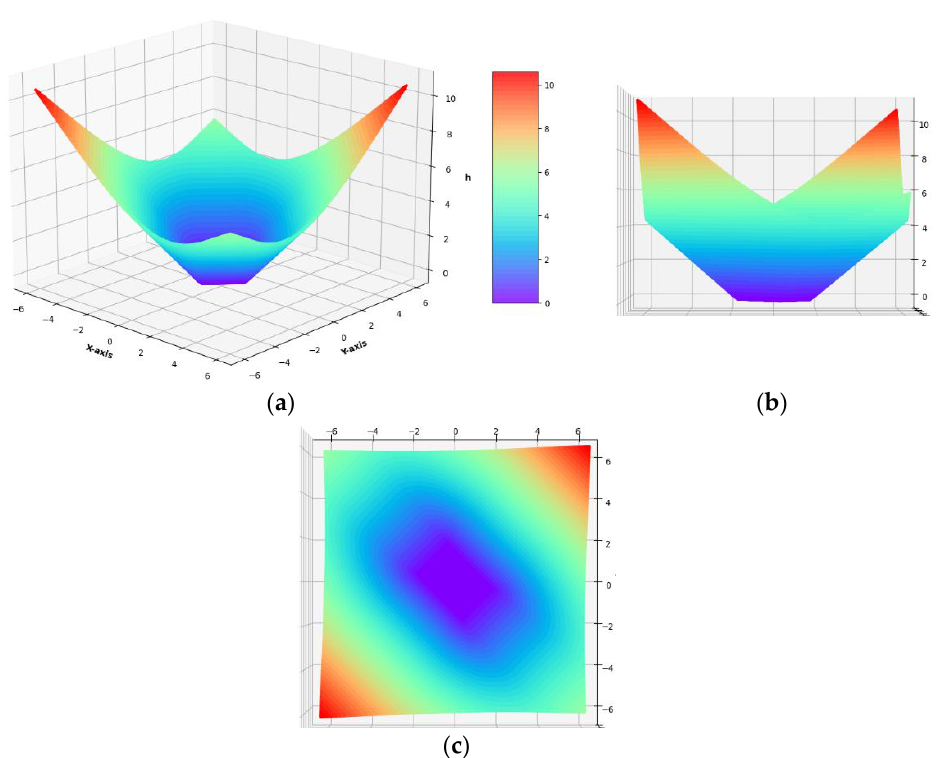
Figure 2. Scatter plots of the function h ( ε ) in the plane of principal strains ε I , ε II denoted as x -axis, y -axis, respectively. The axonometric ( a ), side ( b ) and top ( c ) view, respectively.